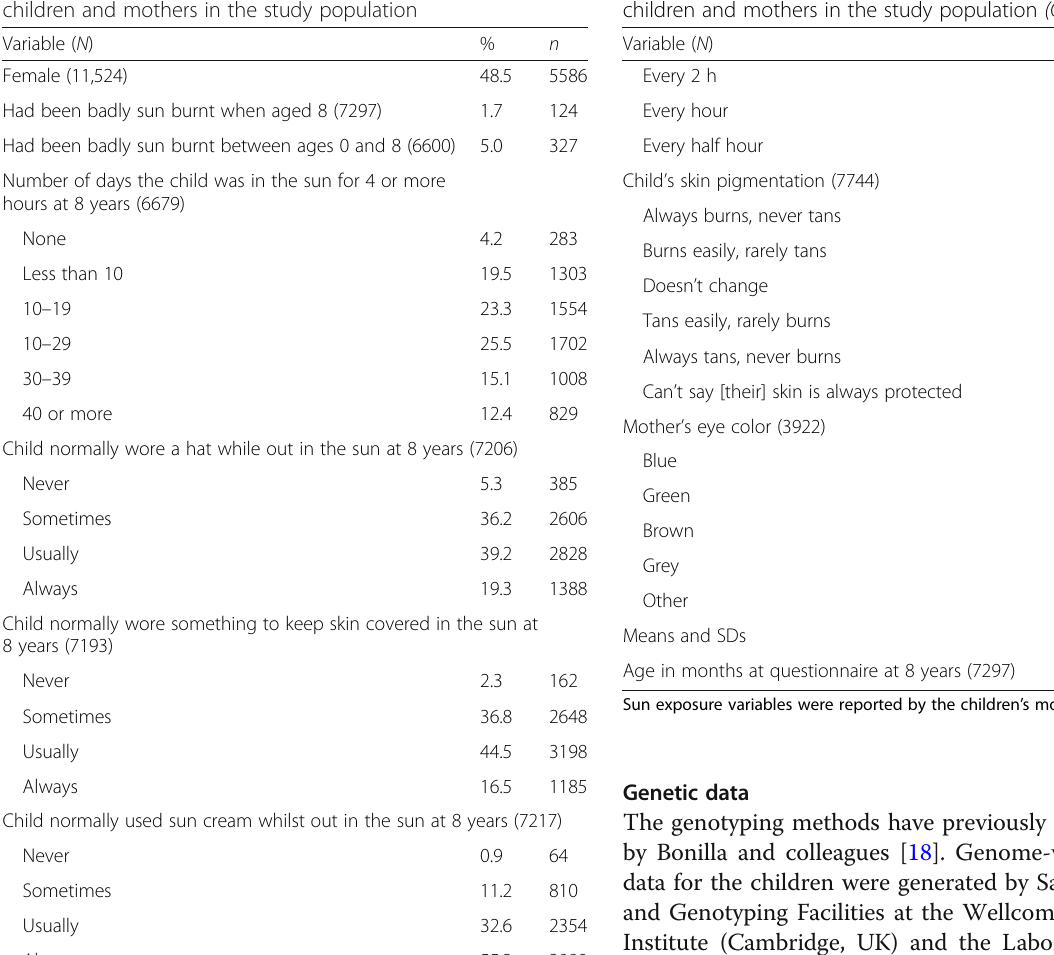
Table 1 Sex, age, sun exposure and pigmentation of the children and mothers in the study population